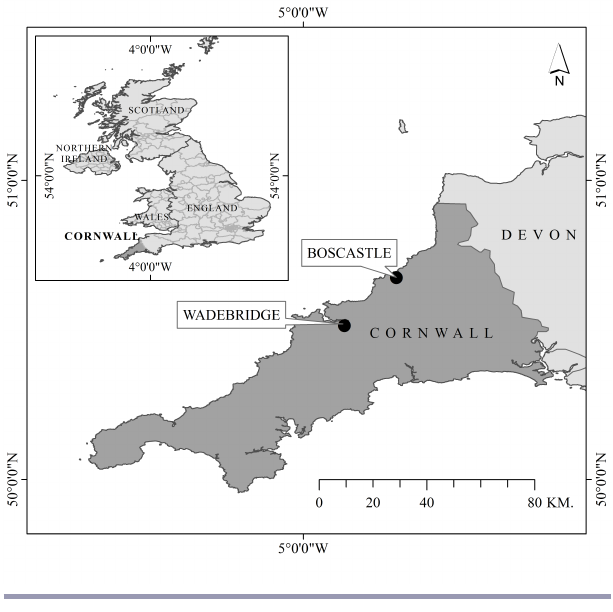
Fig. 1. Location of Boscastle and Wadebridge, north Cornwall, UK.